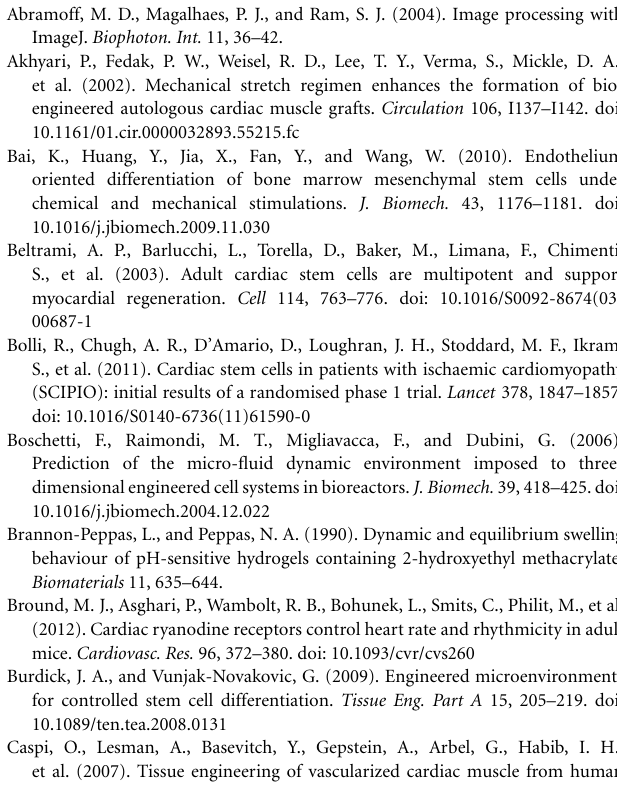
FIGURE 6 | Continued and in a perfusive modular bioreactor. Human cells colonize the scaffold inner layers as shown by nuclei staining at different depths (B) . Side view of cellularizedscaffoldsculturedunderstaticordynamicconditions (C) ;infiltration of GFP- (cardiomyocyte-like cells, green) and VCAM-1-positive cells